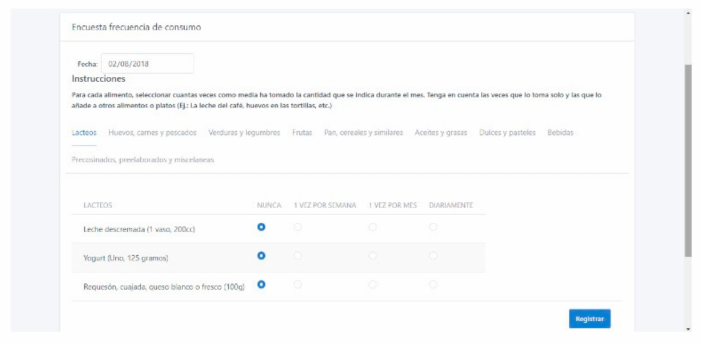
Figure 44. Patient application interface: Recommendations made by the nutritionist. Table 1. Format of the unit and integration tests.